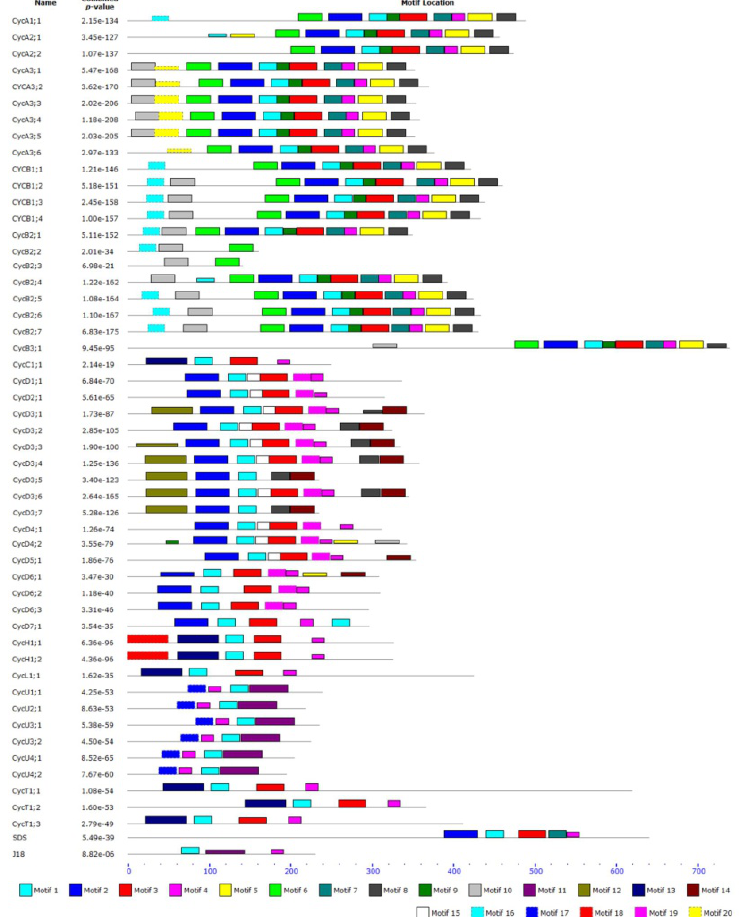
Figure 4. MEME software characterized conserved motifs of tomato cyclins. Different colors represent different motifs and each motif is represented by a box numbered at the bottom. The names of genes and combined P value are exhibited on the left side of the figure. Grey lines represent the non-conserved sequences; the length of protein can be estimated using the scale at the bottom. Motifs 2 and 6 are the cyclin-N domain; Motifs 1,3,7 and 9 are the cyclin-C domain; Motifs 11 and 17 are the U-type cyclin domain; Motifs 14 is the D-type PEST